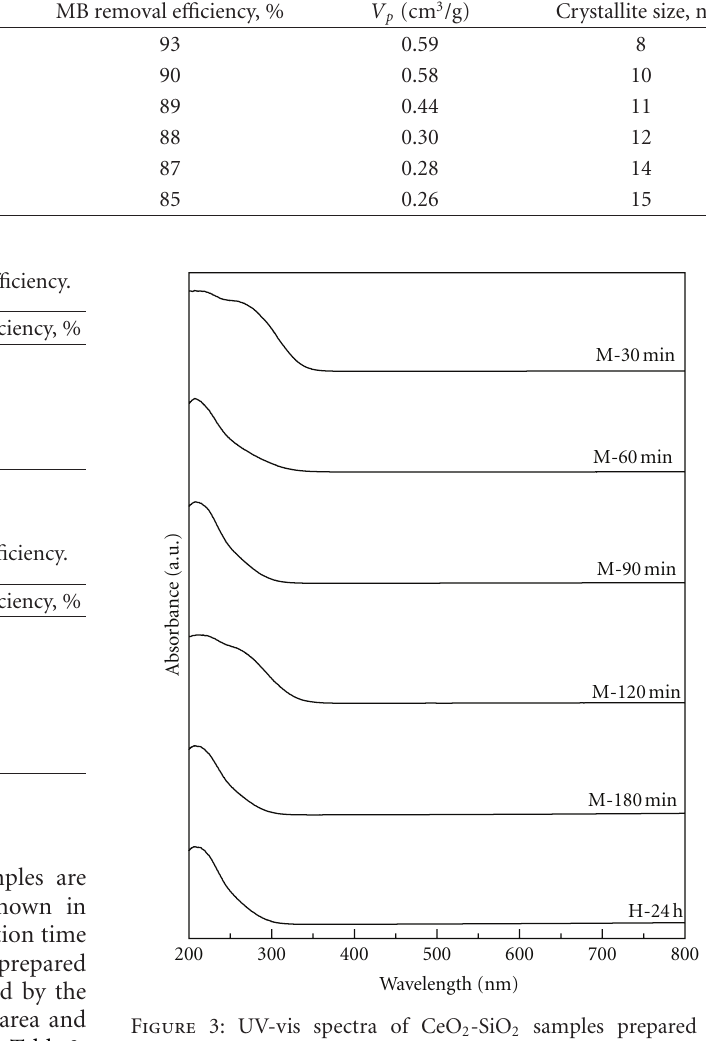
Figure 3: UV-vis spectra of CeO 2 -SiO 2 samples prepared by di ff erent irradiation times and hydrothermal